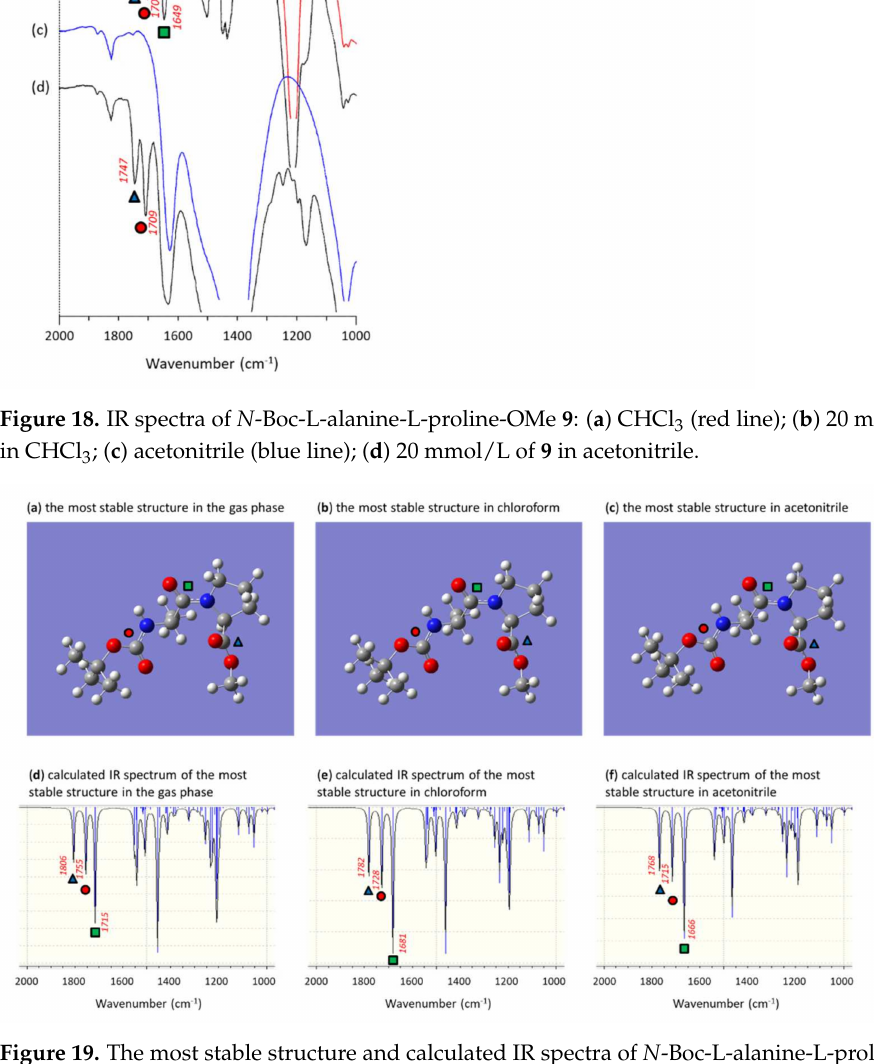
Figure 19. The most stable structure and calculated IR spectra of N -Boc-L-alanine-L-proline-OMe 9 : ( a ) the most stable structure in the gas phase, ( b ) the most stable structure in chloroform, ( c ) the most stable structure in acetonitrile, ( d ) calculated IR spectrum in the gas phase, ( e ) calculated IR spectrum in chloroform, ( f ) calculated IR spectrum in